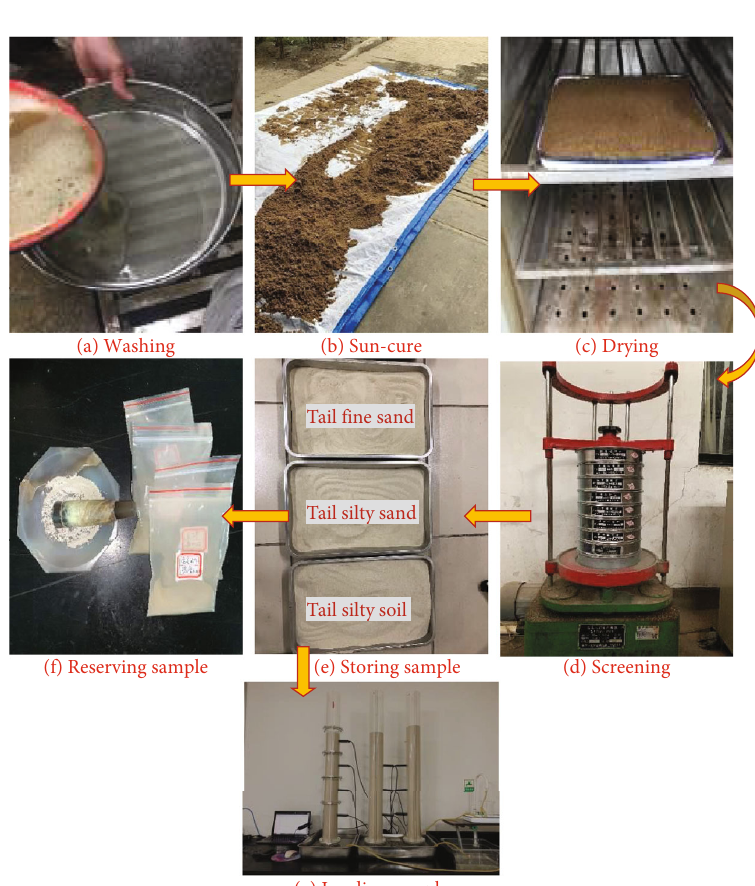
Figure 4: Preparation process of tailing